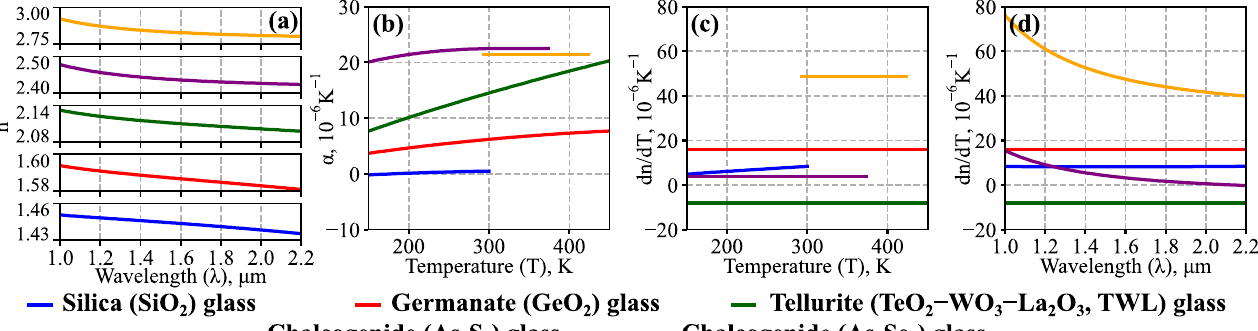
Figure 2. Optical and thermo-optical glass parameters used in numerical simulations (the corre- sponding literature sources are provided in Table 1). ( a ) Glass refractive index as a function of light wavelength λ . ( b ) Temperature dependence of thermal expansion coefficient α . ( c , d ) Thermo-optic coefficient dn / dT as a function of temperature T at λ = 1.55 μ m ( c ) and as a function of λ at room temperature T 0 = 293 K ( d ).